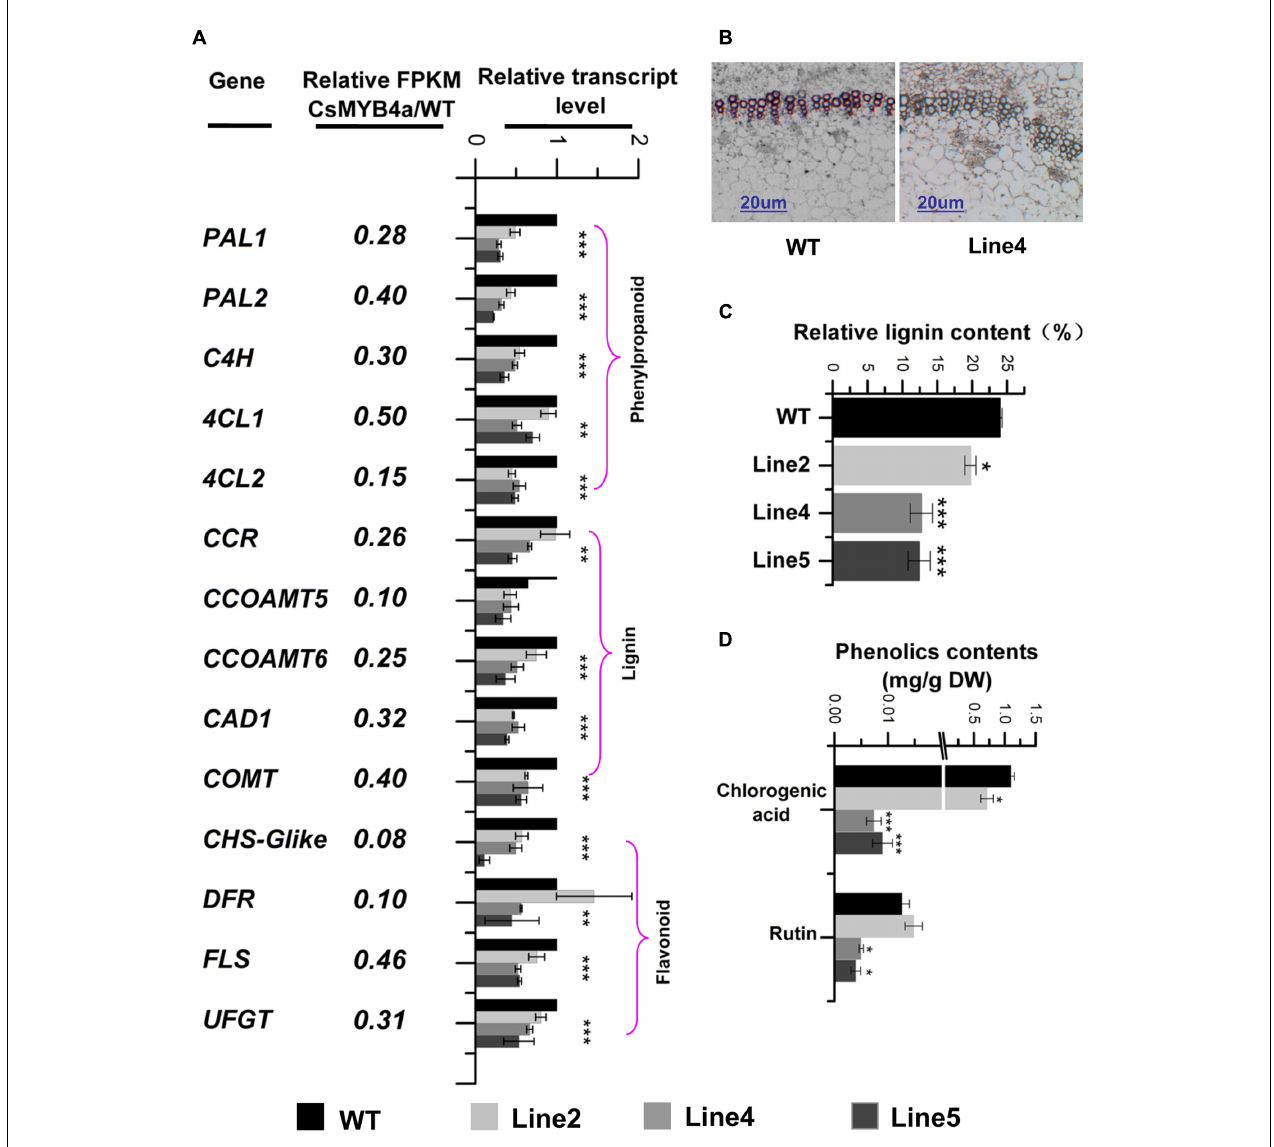
FIGURE 5 | Effect of CsMYB4a overexpression on the transcriptional level of 14 phenylpropanoid pathway genes and the level of lignin, chlorogenic acid and rutin. (A) Ratio values were obtained by dividing each gene RPKM value in CsMYB4a transgenic plants by its RPKM value in wild-type plants. qRT-PCR analysis of each gene in three different transgenic lines and wild-type plants. (B) Cross-sectional images of stems in wild-type and CsMYB4a transgenic tobacco plants revealing lignin via phloroglucinol-HCl staining. (C) Relative lignin content (proportional to dry weight) of wild-type plants and different lines of CsMYB4a transgenic tobacco plants. (D) Level of chlorogenic acid and rutin in seedlings of wild-type and CsMYB4a transgenic plants. Values represent the mean ± SD ( n = 3). Asterisks on top of the bars indicate that the values are significantly different from the equivalent control ( ∗ P < 0.05, ∗∗ P < 0.01, ∗∗∗ P <